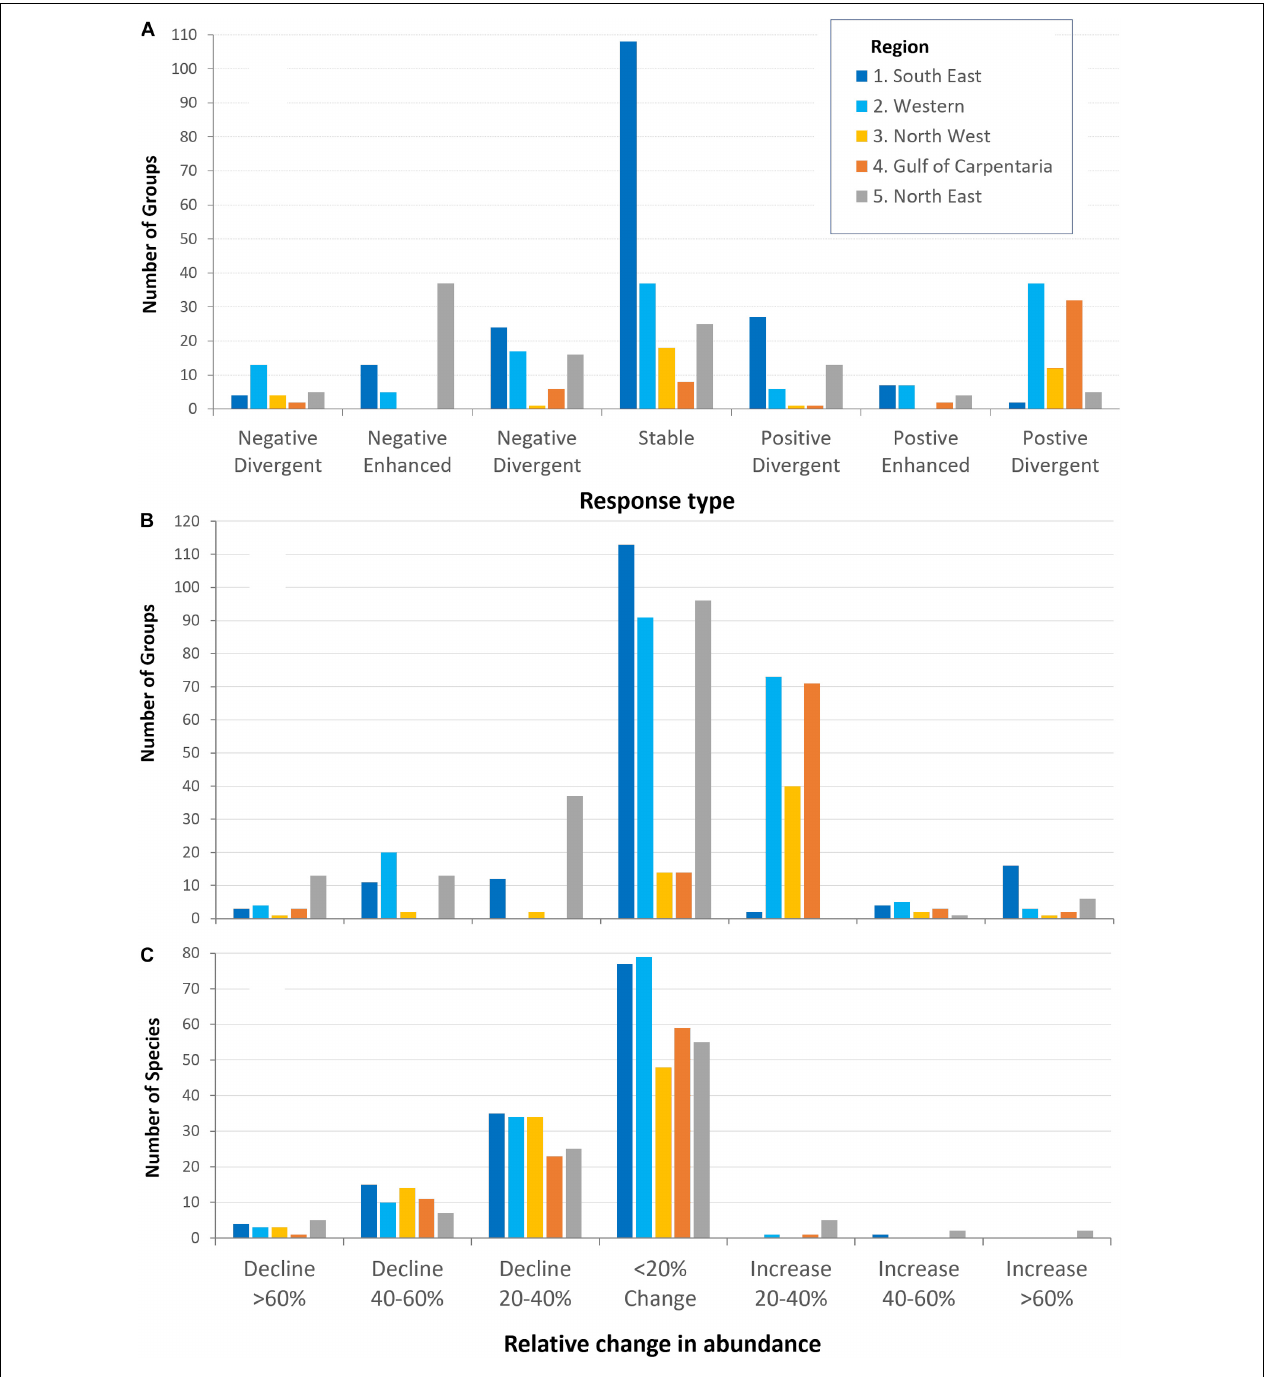
FIGURE 4 | Projected response types or abundance changes (sensitivities) to RCP8.5 greenhouse gas emission scenario (combined response to fisheries and climate change) for different assessment regions around Australia based on (A,B) regional ecosystem models with trophic linkages (on functional groups), and (C) species distribution models without trophic linkages (on individual